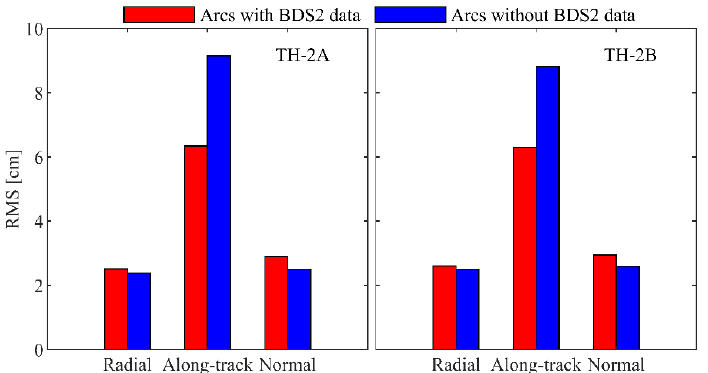
Figure 11. Orbit differences between BDS2- and GPS-based POD during the arcs with and without BDS2 data.